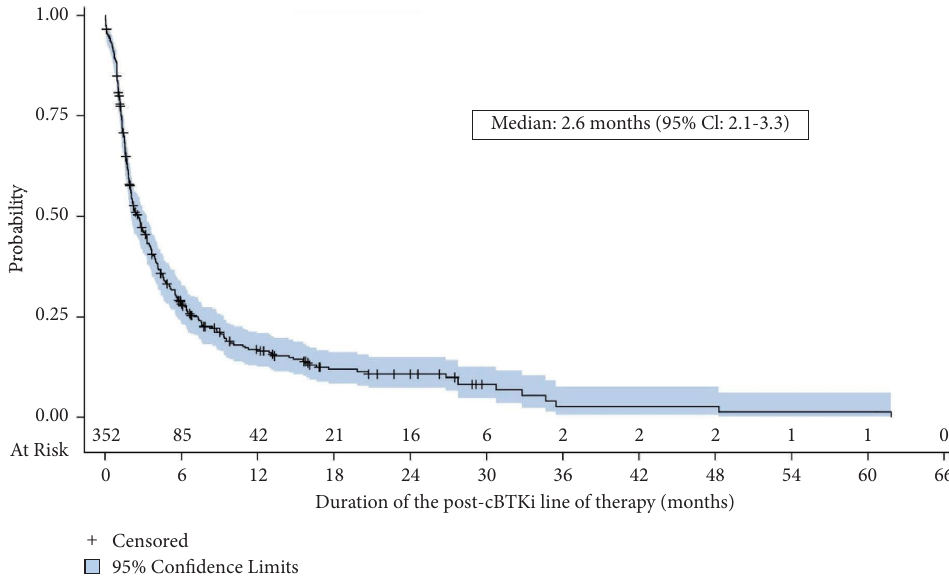
Figure 3: Duration of the immediate post-cBTKi line of therapy ( n � 352). Abbreviations: cBTKi � covalent bruton tyrosine kinase in- hibitor; CI � confdence interval.